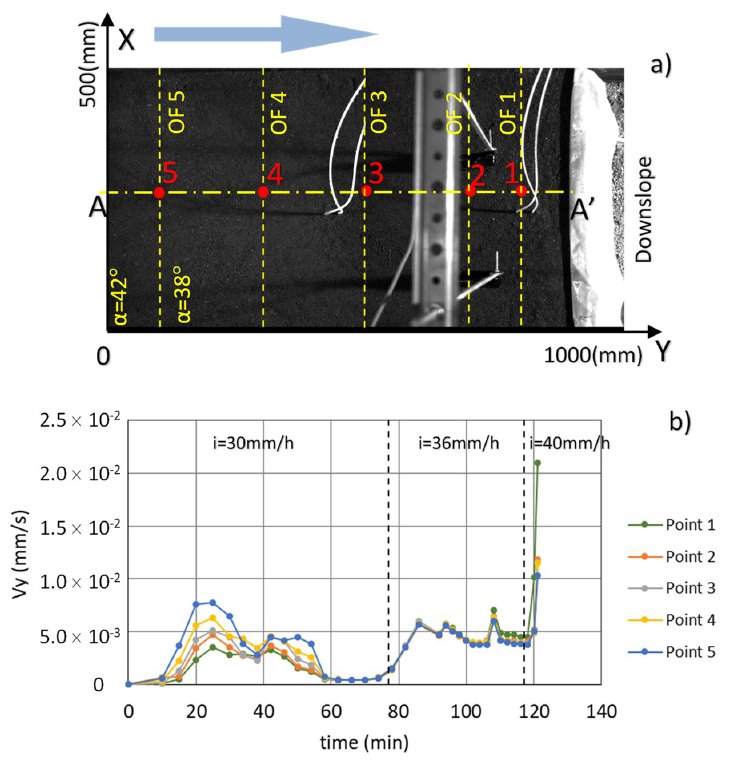
Figure 11. PIV data: ( a ) ground surface and monitored points; ( b ) displacement rate.